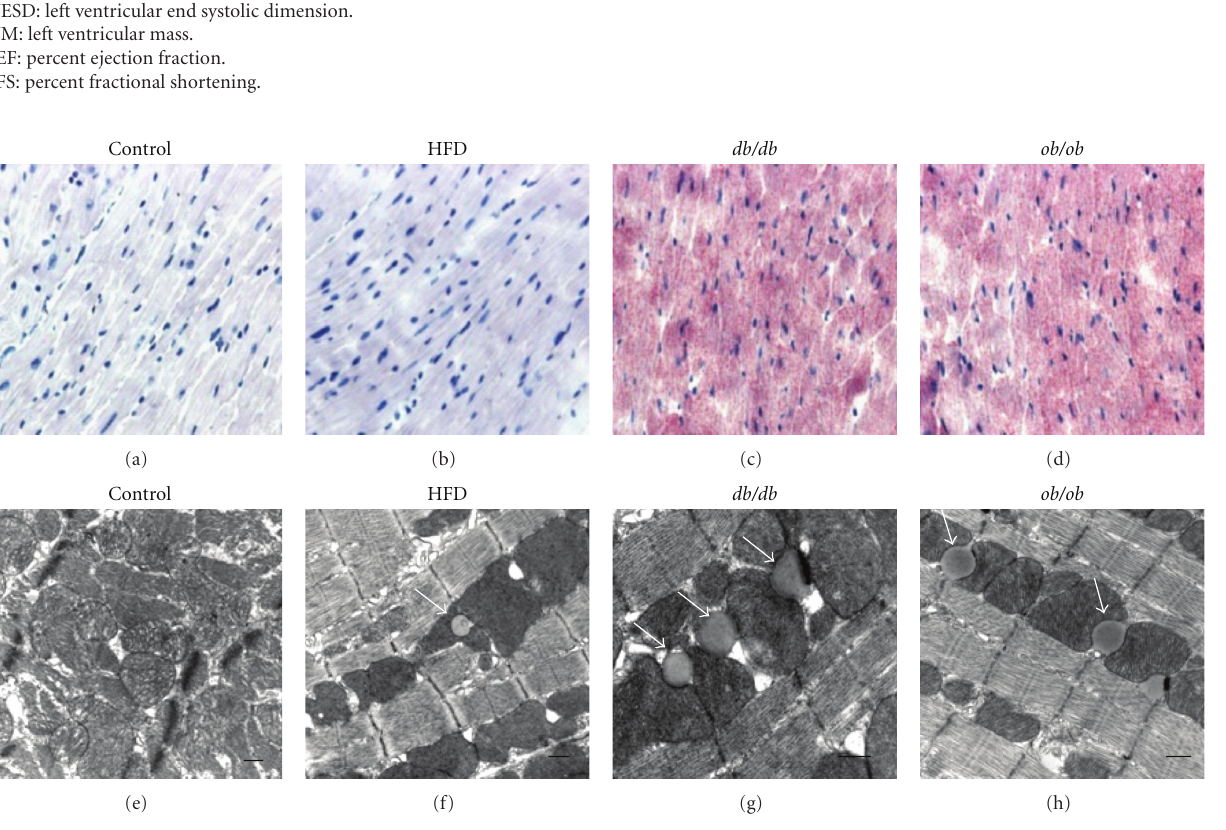
Figure 2: Cardiac histology. ((a), (b), (c), and (d)). Representative Oil-Red-O-(ORO-) stained sections of hearts from (a) control, (b) high fat diet-fed (HFD), (c) db/db , and (d) ob/ob mice. Lipid droplets were rare in control hearts and uncommon in HFD mice despite a ∼ 12-fold increase in cardiac triglyceride content in the latter group. There was an obvious increase in ORO-stainable lipid in the hearts of ob/ob and db/db mice. ((e), (f), (g), and (h)). Transmission electron microscope images of (e) control, (f) HFD, (g) db/db, and (h) ob/ob mice. Lipid droplets (arrows) were rare in control hearts, but individual droplets could be found in many fields in the HFD group. Lipid droplets were larger and much more common in db/db and ob/ob hearts, with multiple droplets typically being observed in most fields. The scale bar indicates 500nm. Lipid droplets in the heart were almost uniformly in direct contact with